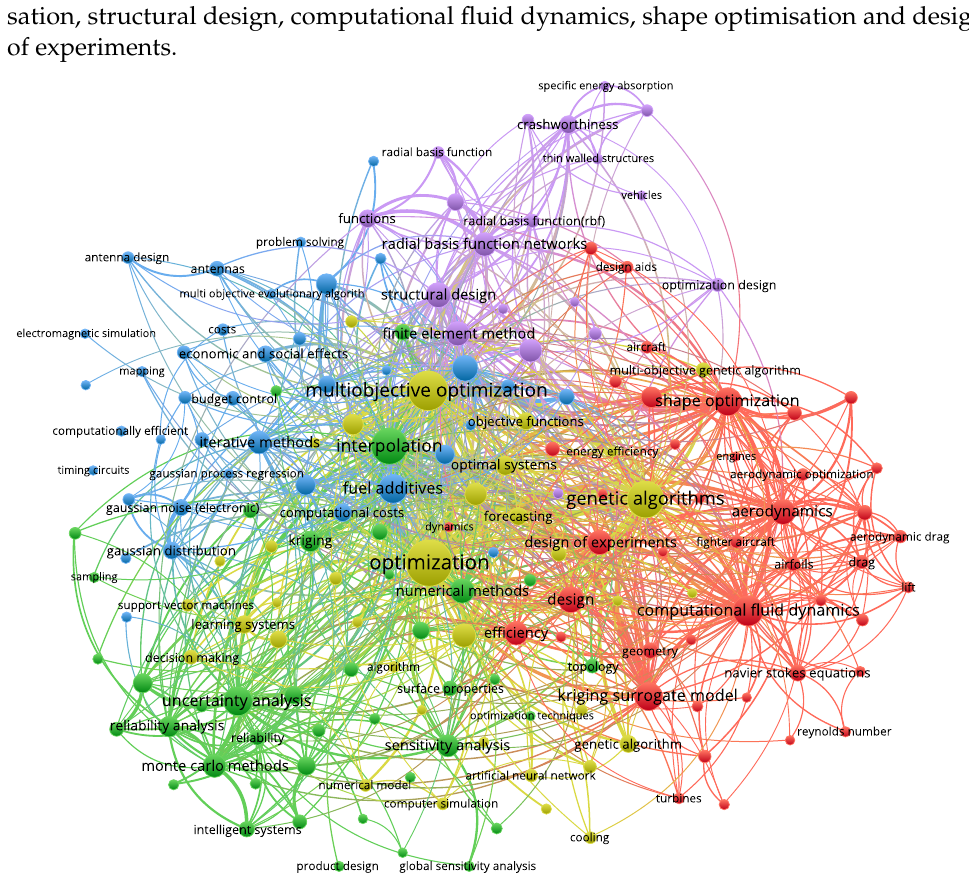
Figure 1. The network of keywords found in publications defines thematic groups connected to the surrogate models and optimisation or control in engineering (between 2017 and